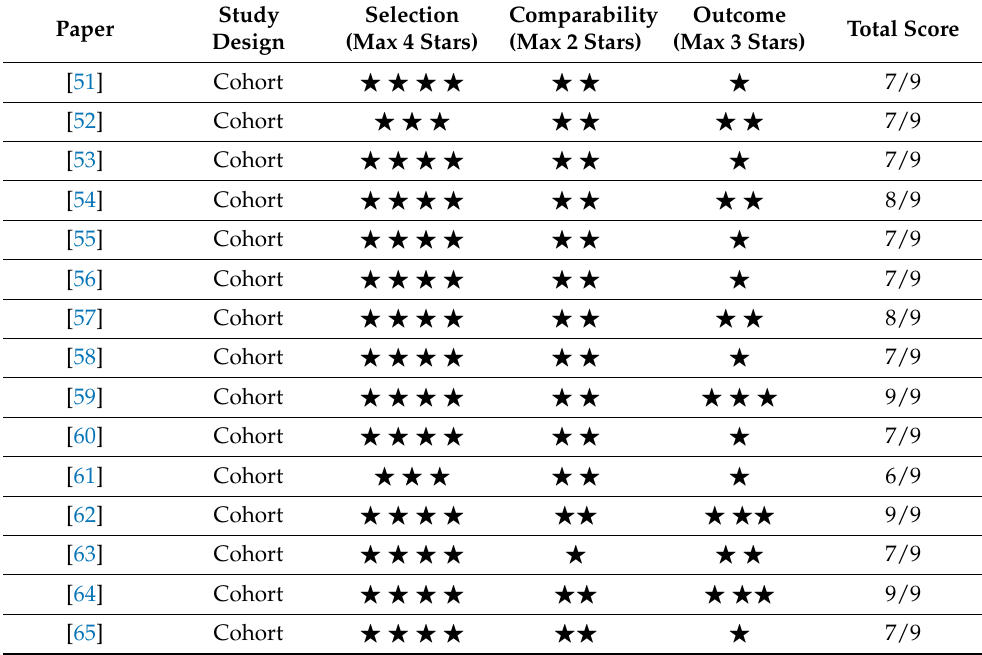
Table 2. Newcastle–Ottawa scale (NOS) quality assessment.